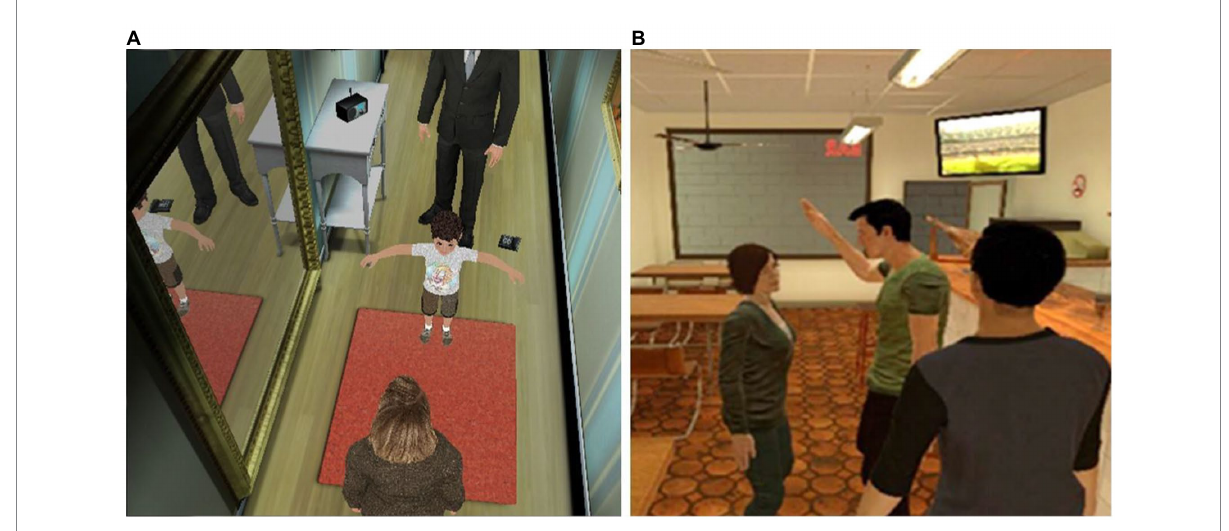
FIGURE 5 Studies using virtual environments displaying intimate partner violence that is experimented from two different perspectives. (A) The participant is embodied as a child and witnesses the abuse by the male avatar towards the female (still taken from the experiment described in Seinfeld et al. (2023)). (B) A scenario in a bar where the participant witnesses an attack by a virtual man on his female partner. This is shown from a third-person perspective from behind the virtual body of the participant. Source: Johnston et al. (2021). Reproduced with